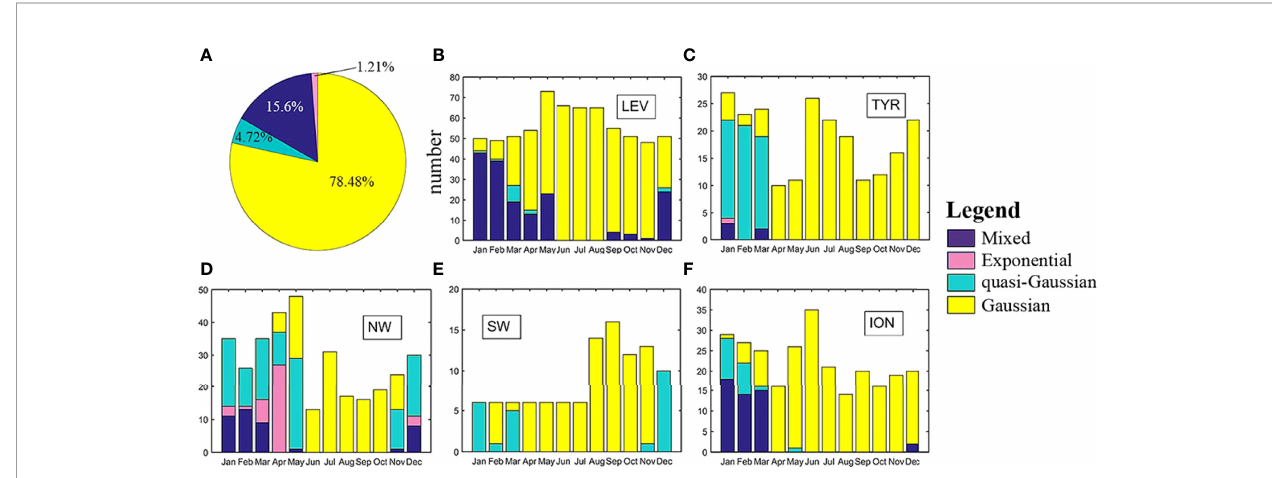
FIGURE 9 | Spatial and temporal patterns of the Chl-a vertical pro fi les measured in the Mediterranean Sea. The pie chart in panel (A) shows the percentage of each pro fi le type of all measurements. The histograms from panel (B – F) show the occurrence frequencies of the different types of Chl-a vertical pro fi les in the different subsea areas and